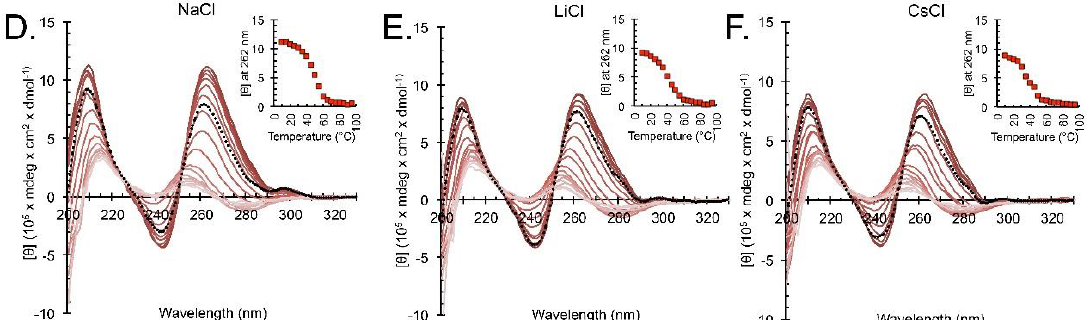
Figure 3. CD thermal denaturation shows reversible structural transition of a G4 formed by hex4 _A5U with different cations. Oligonucleotides were annealed in 10 mM TBA buffer supplemented with 100 mM of KCl ( A ), NaCl ( B ), LiCl ( C ), CsCl ( D ), buffer alone ( E ), or water ( F ). In all conditions, we observed an overall decrease in CD signal intensity with an increase in temperature. Melting G4s annealed in KCl resulted in a sigmoidal curve with a T 1/2 of 58 °C. Melting in NaCl, LiCl, and CsCl revealed a two-state behavior indicative of a structural transition from a G4 to ssDNA in which a sigmoidal phase was followed by a linear phase. Melts for water and TBA buffer alone were linear and represented unstacking of the ssDNA bases. Thermal unfolding of the secondary structure was reversible, indicated by the dashed black line that corresponds to spectra collected immediately after the samples were cooled to 20 °C. Insets: plots of molar ellipticity at 262 nm versus temperature.